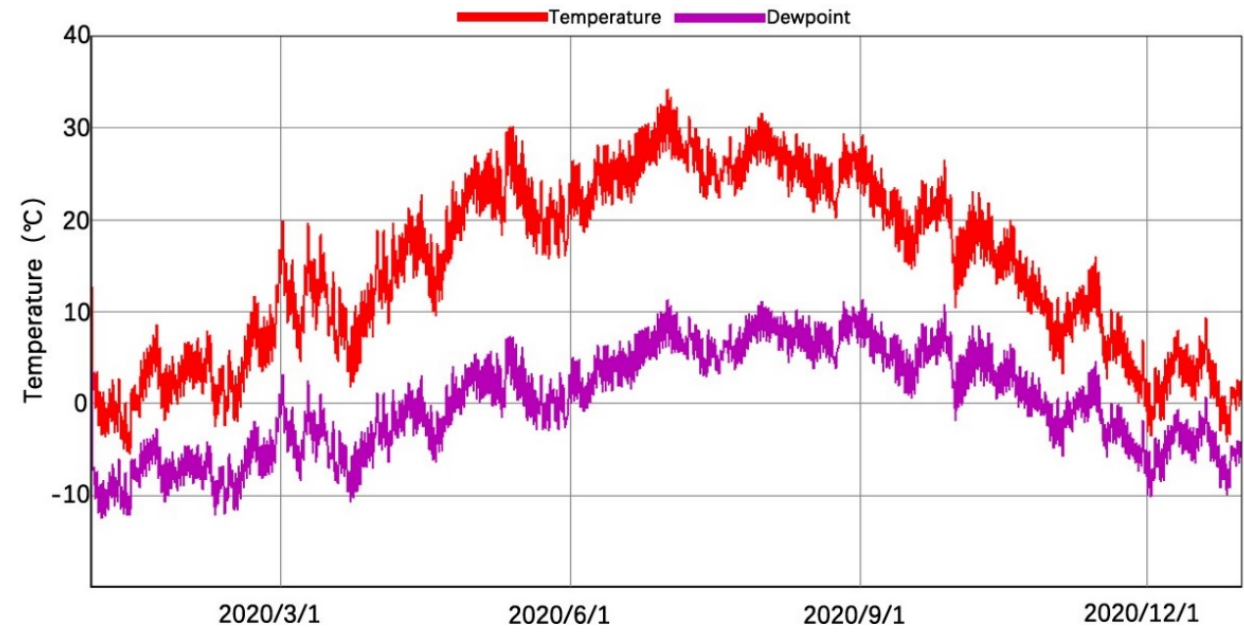
Figure 20. Optimized wall dewpoint and temperature of monitoring point 2.